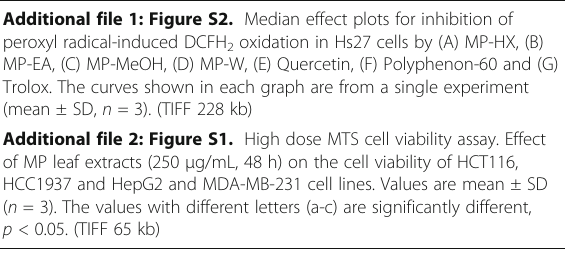
Additional file 1: Figure S2. Median effect plots for inhibition of peroxyl radical-induced DCFH 2 oxidation in Hs27 cells by (A) MP-HX, (B) MP-EA, (C) MP-MeOH, (D) MP-W, (E) Quercetin, (F) Polyphenon-60 and (G) Trolox. The curves shown in each graph are from a single experiment (mean ± SD, n = 3). (TIFF 228 kb) Additional file 2: Figure S1. High dose MTS cell viability assay. Effect of MP leaf extracts (250 μ g/mL, 48 h) on the cell viability of HCT116, HCC1937 and HepG2 and MDA-MB-231 cell lines. Values are mean ± SD ( n = 3). The values with different letters (a-c) are significantly